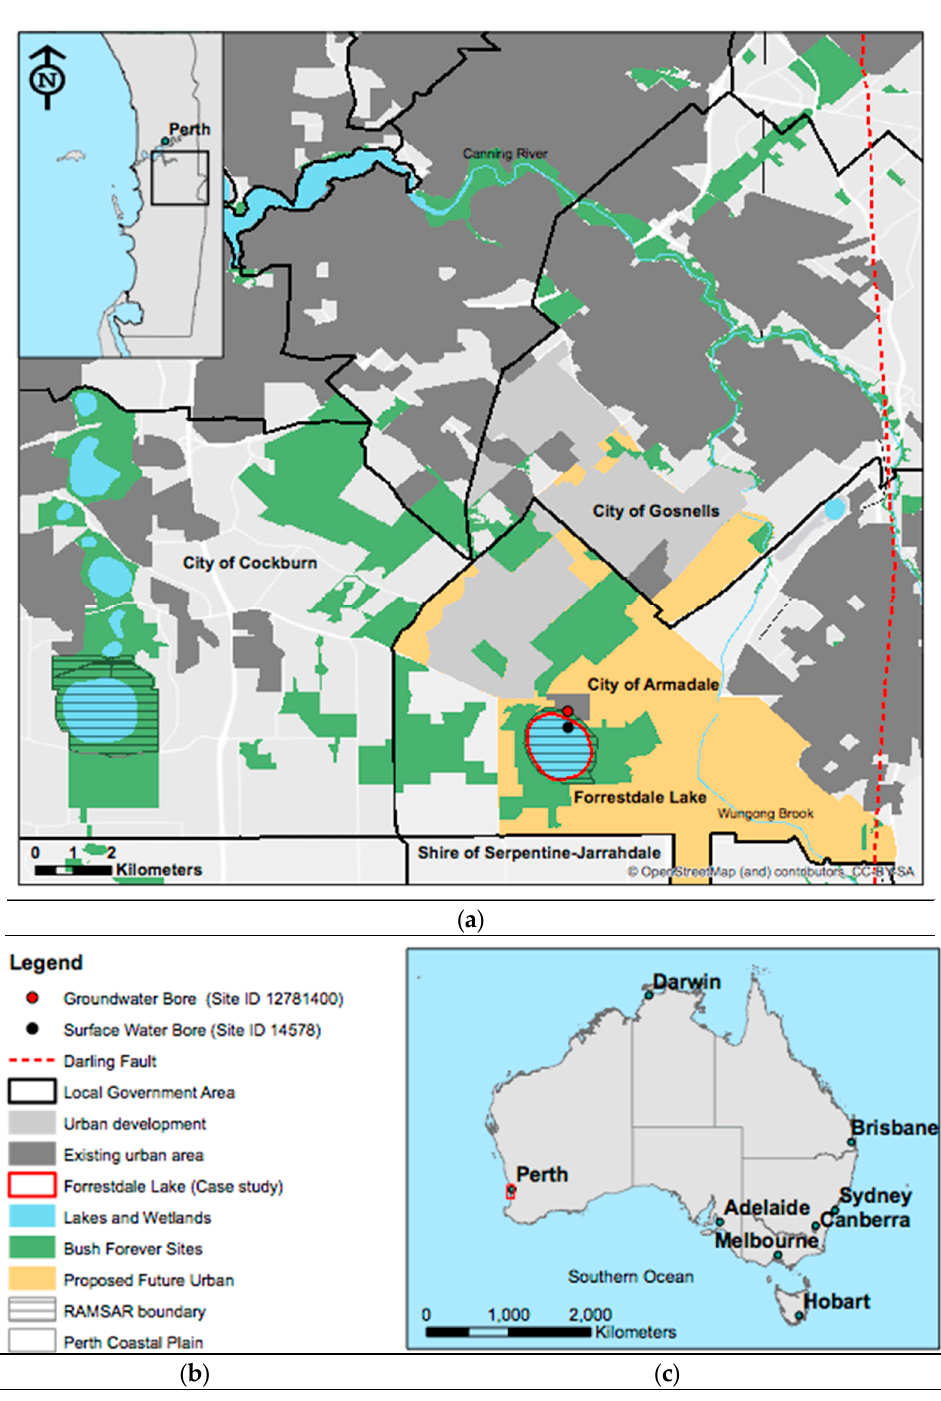
Figure 2. Location of Forrestdale Lake (32° 09’ 30” S, 115° 56’ 16” E) within its groundwater catchment, showing the increasing urbanisation in the catchment, the multiple management authorities, and protection policies (Map projection: GDA94). ( a ) Catchment characteristics of Forrestdale Lake; ( b ) Legend; ( c ) Location of Forrestdale Lake.